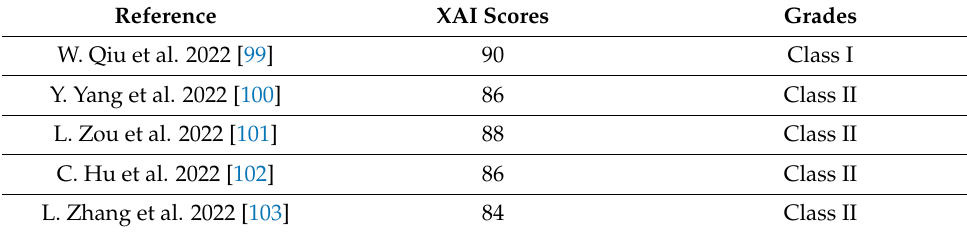
Table 10. Grades for the XAI Scoring